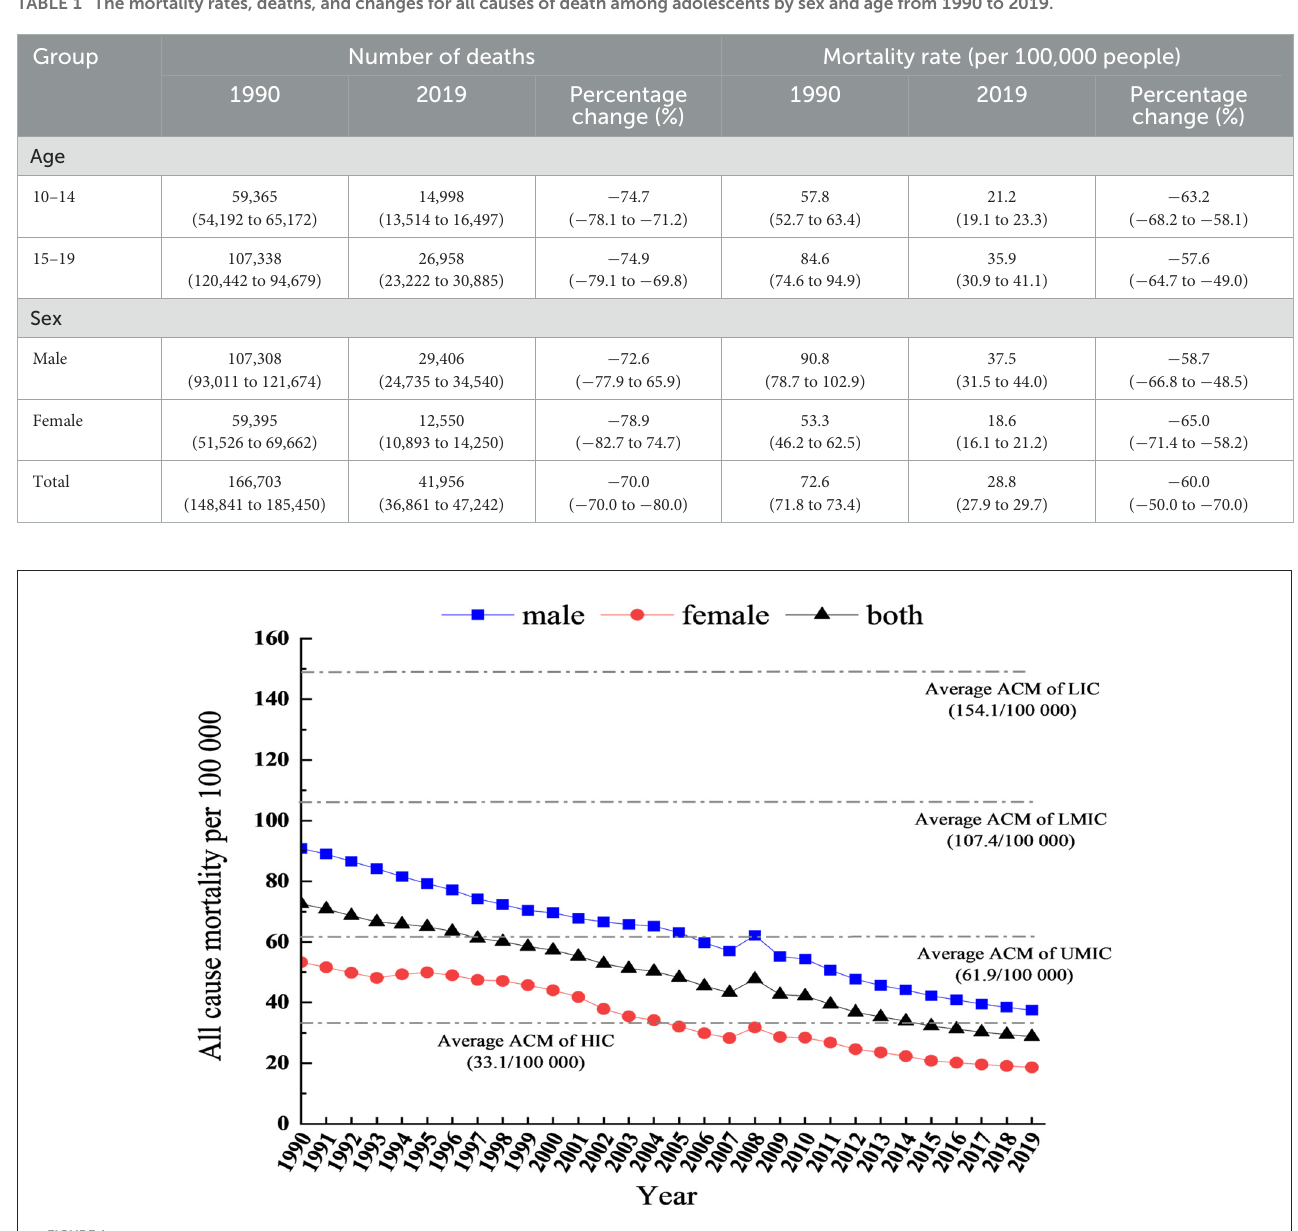
FIGURE1 The trends of all causes of mortality rates in China, aged 10–19 years. ACM, All-cause mortality; HIC, High-income countries; UMIC, Upper-middle income countries; LMIC, Lower-middle income countries; LIC, Lower income